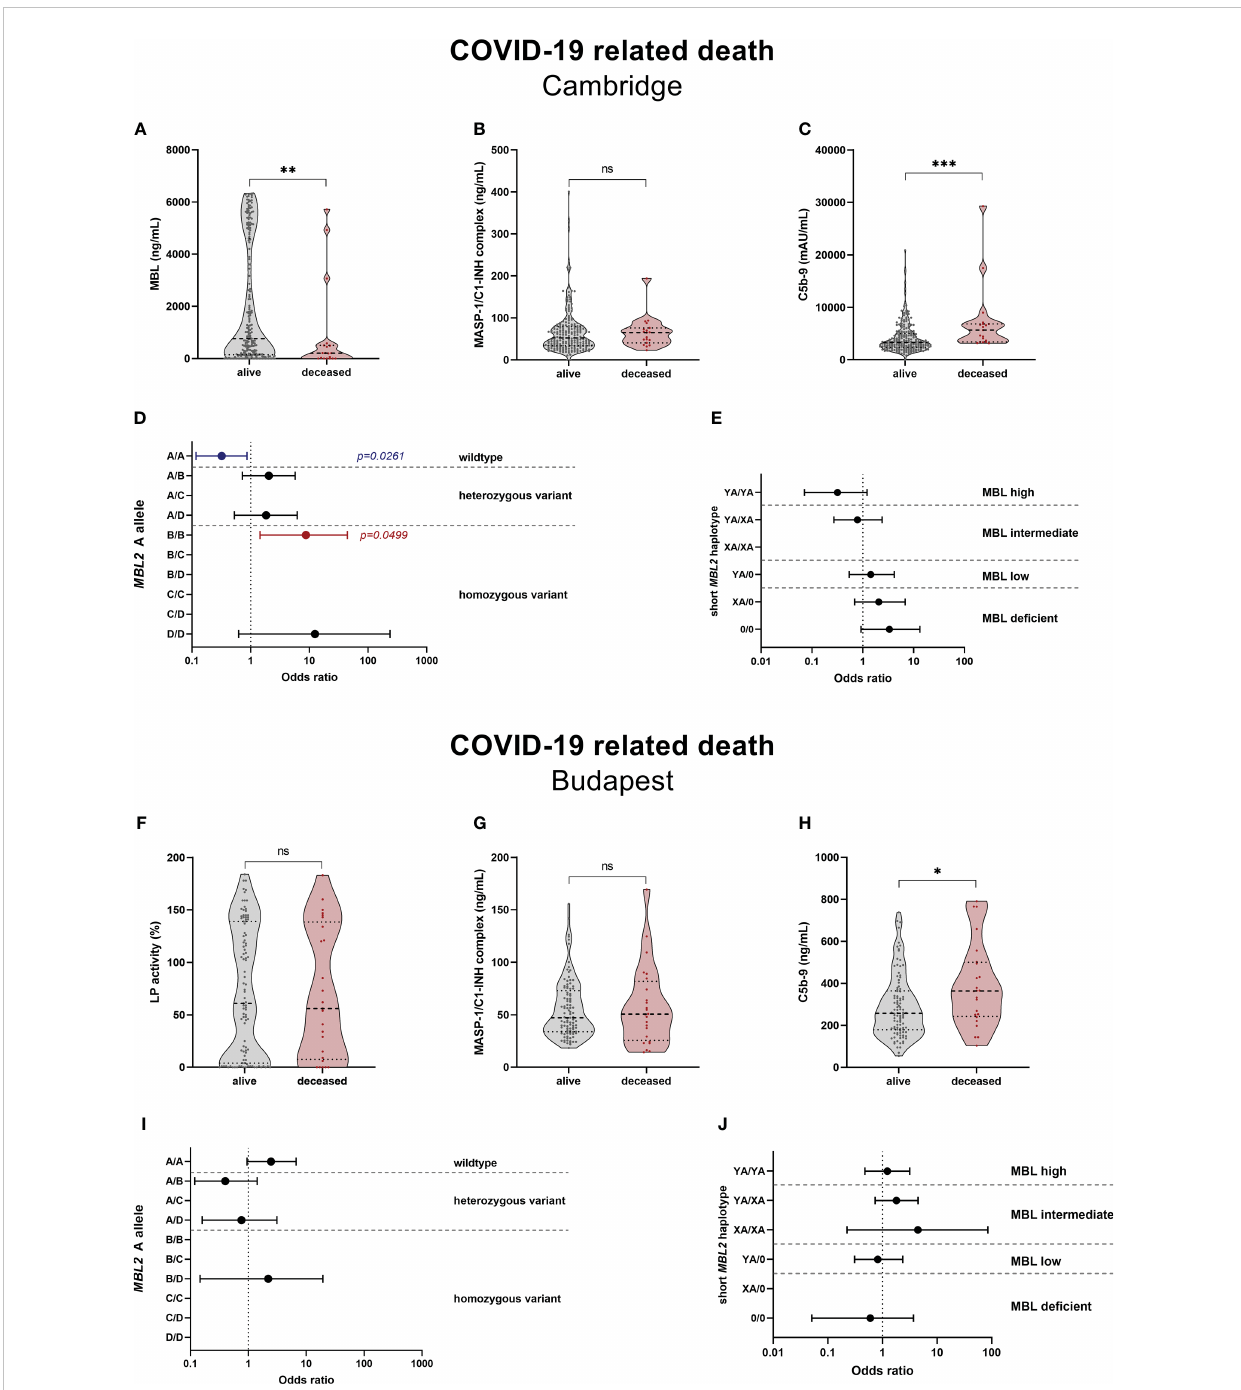
FIGURE 9 Relationship between complement markers, MBL genotype and mortality in COVID-19. Levels of complement markers MBL (A) , MASP-1/C1-INH complex (B) and TCC/C5b-9 (C) in the Cambridge cohort and Lectin pathway activity (F) , MASP-1/C1-INH complex (G) and TCC/C5b-9 (H) of the Budapest cohort were strati fi ed according to survival (alive vs. deceased). Differences between the two groups were analysed using the Mann- Whitney test, while asterisks indicate signi fi cant differences (* p<0.05, ** p<0.01, *** p<0.001). Non-signi fi cant differences are indicated (ns). Forest plot displaying Odds ratios (ORs) with 95% con fi dence intervals (CIs) for COVID-19 related death in individuals, strati fi ed according to the MBL2 A allele carrier state (D) Cambridge, (E) Budapest) as well as according to the MBL2 genotype groups (I) Cambridge, (J) Budapest). Odds ratios of 0 or in fi nite are not indicated on the forest plots. p-values are presented as non-corrected for multiple testing. Threshold for signi fi cance taking into account multiple testing are p=0.0050 for the MBL2 A allele, and p=0.0083 for the short MBL2 haplotype (Benjamini-Hochberg correction). MASP- 1/C1-INH, MASP-1/C1-INH complex; LP, lectin pathway